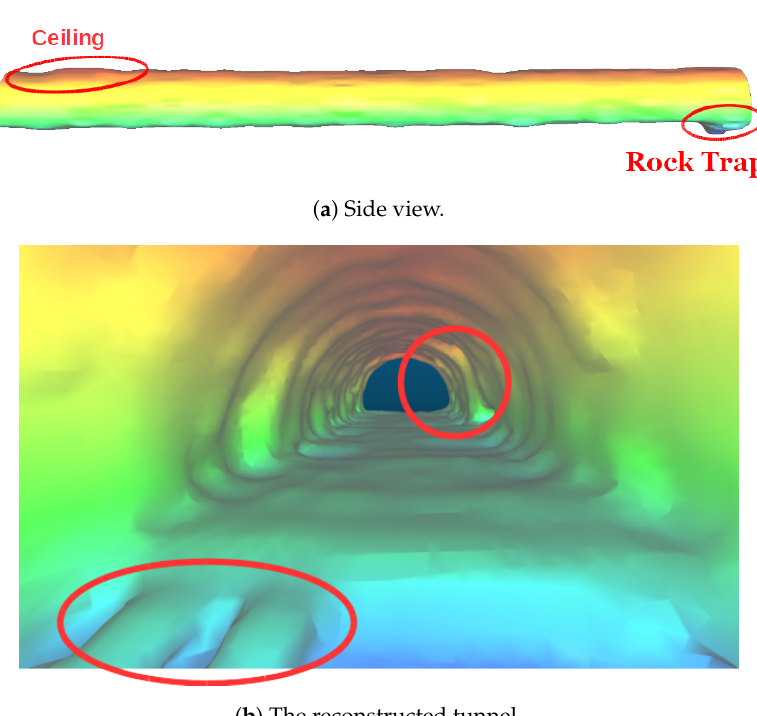
Figure 17. The reconstructed tunnel. Regions of interest are marked in red. Note we can detect height differences in the ceiling and also some details of the end of the rock trap. Due to poor sampling along the tunnel length we cannot get a lot of details of the side tunnel we saw in previous